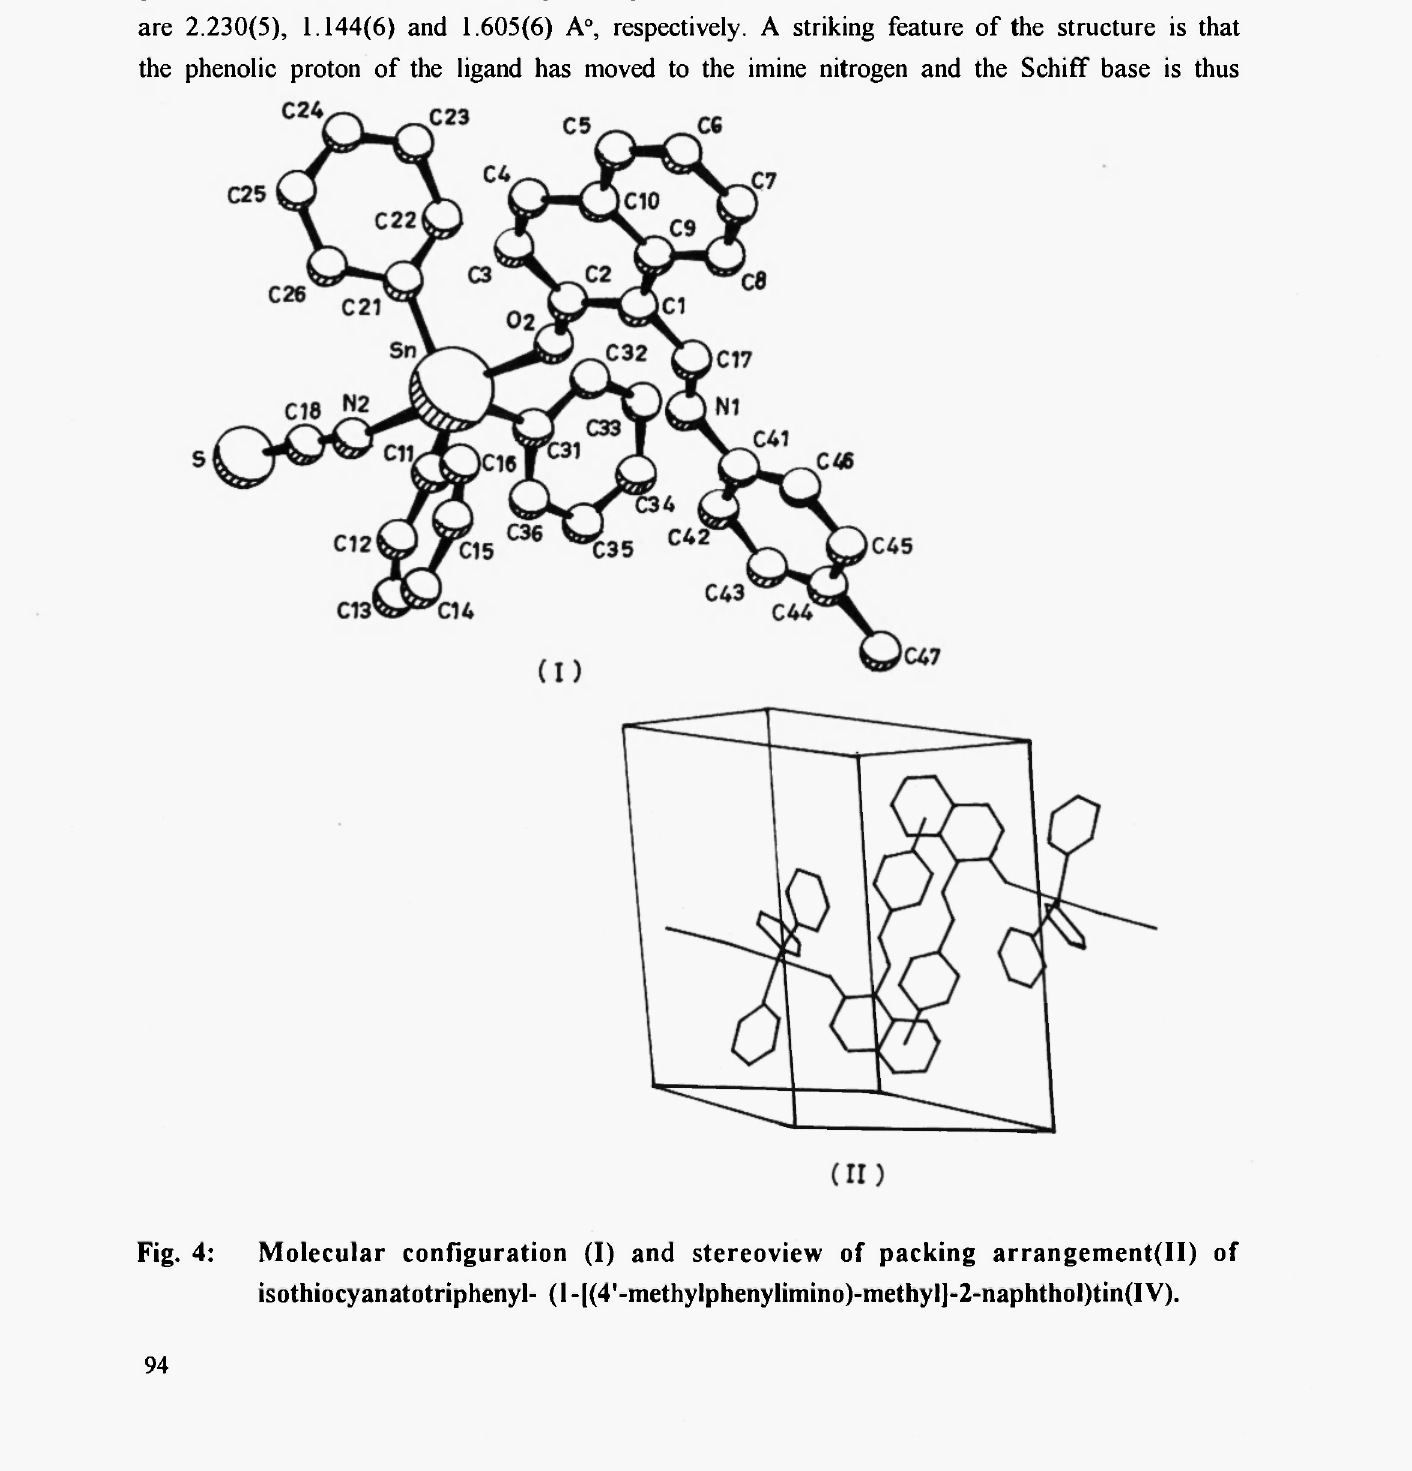
Fig. 4: Molecular configuration (I) and stereoview of packing arrangement(II) of isothiocyanatotriphenyl-